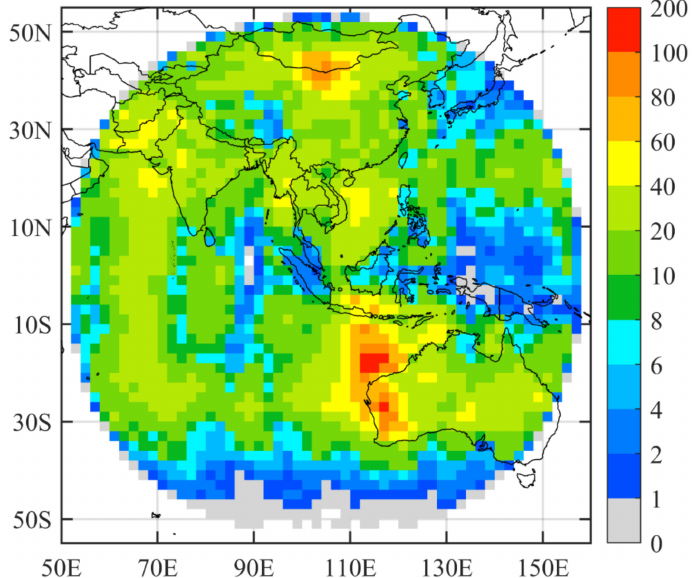
Figure 5. Distribution of clear–sky data counts ( × 10 3 ) for FY–4A/AGRI with satellite zenith angles less than 60 ◦ collocated with MODIS cloud mask products in January, April, July, and October